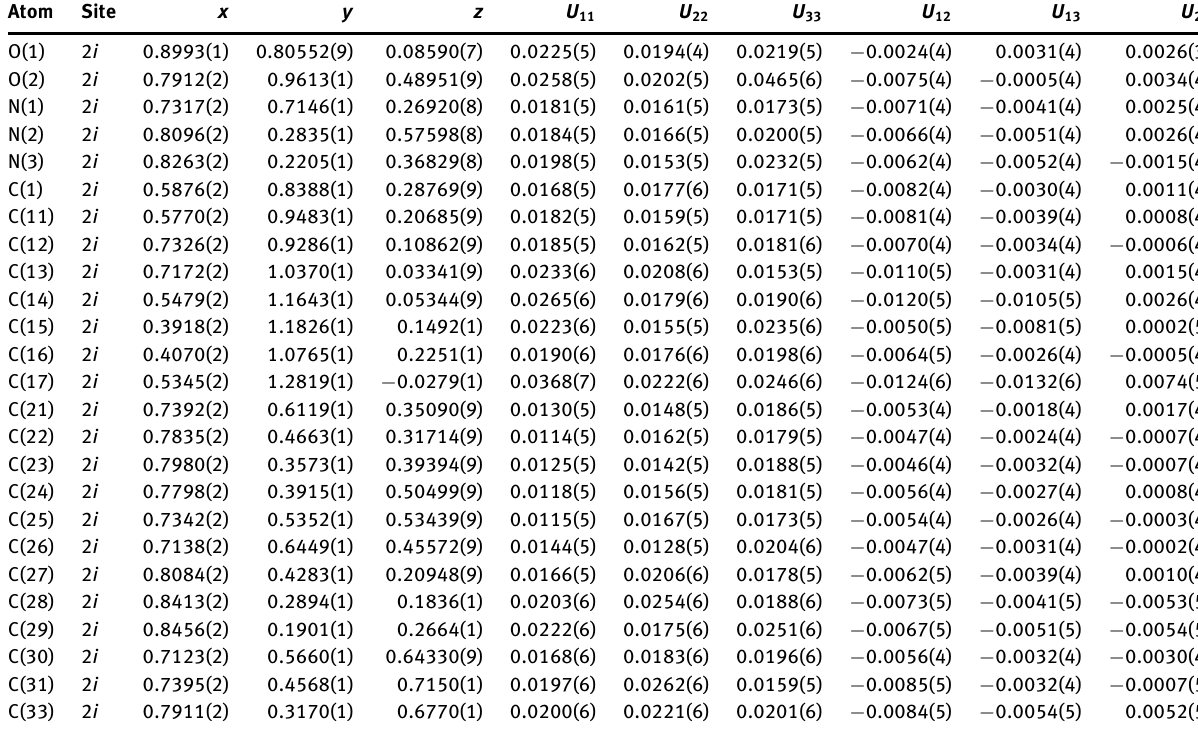
Table 3: Atomic displacement parameters (Å 2